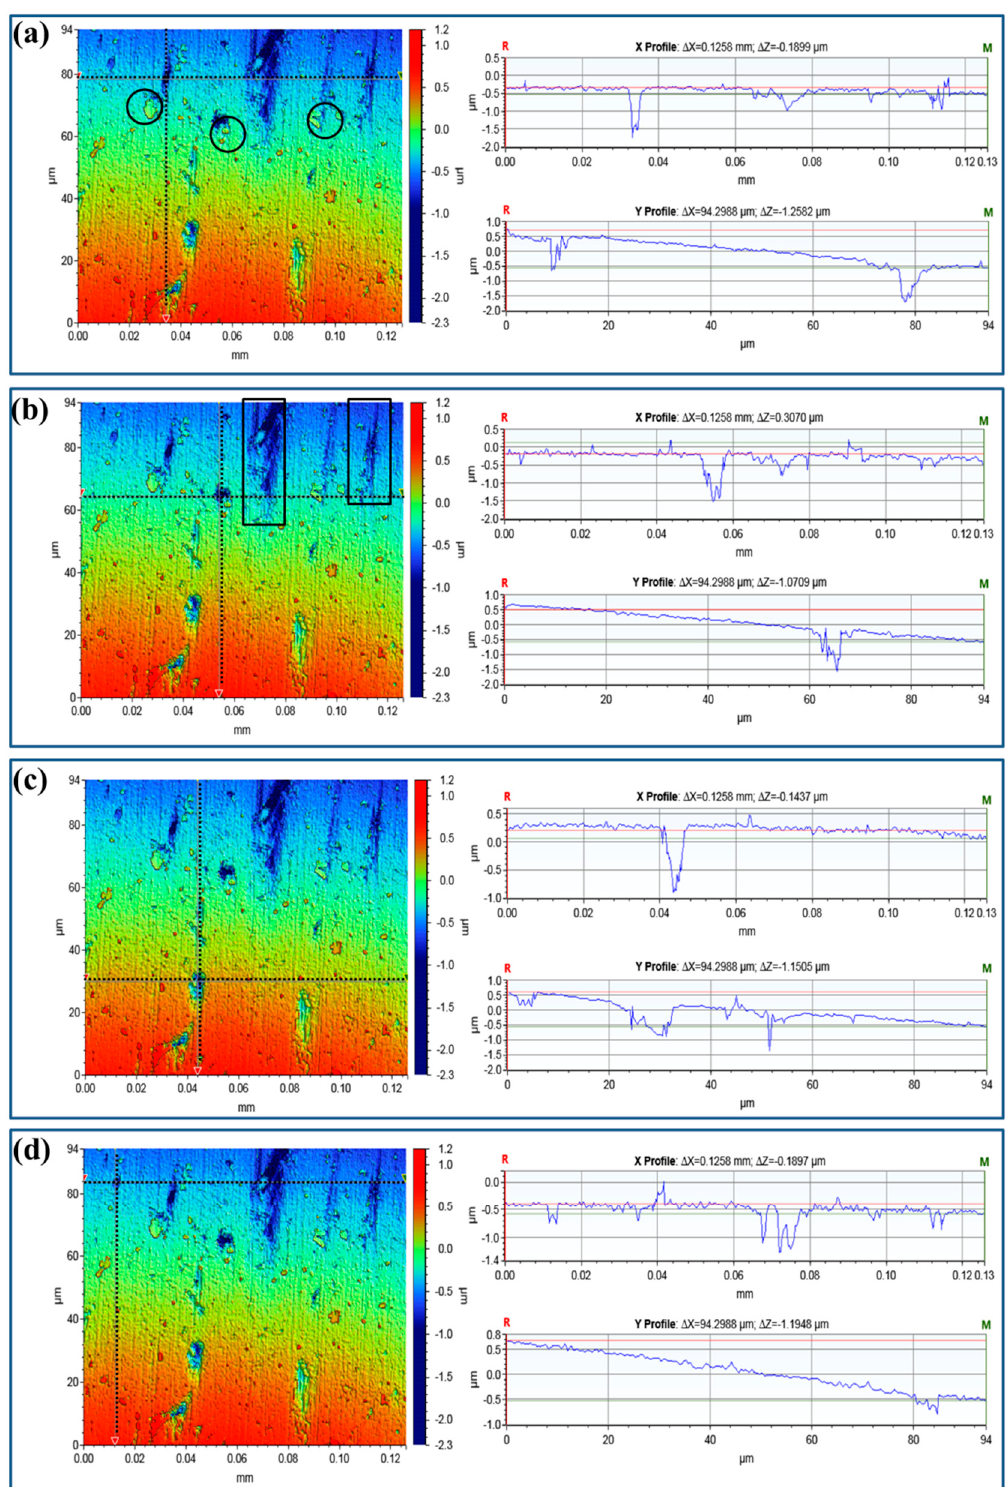
Figure 7. Three-dimensional optical profilometry images of Sample-Z after constant immersion for 240 h in 3.5 wt % NaCl together with the line profiles of the measured pits. ( a – d ) highlight the line profiles crossing the selected pit, which are identified these black dot lines.